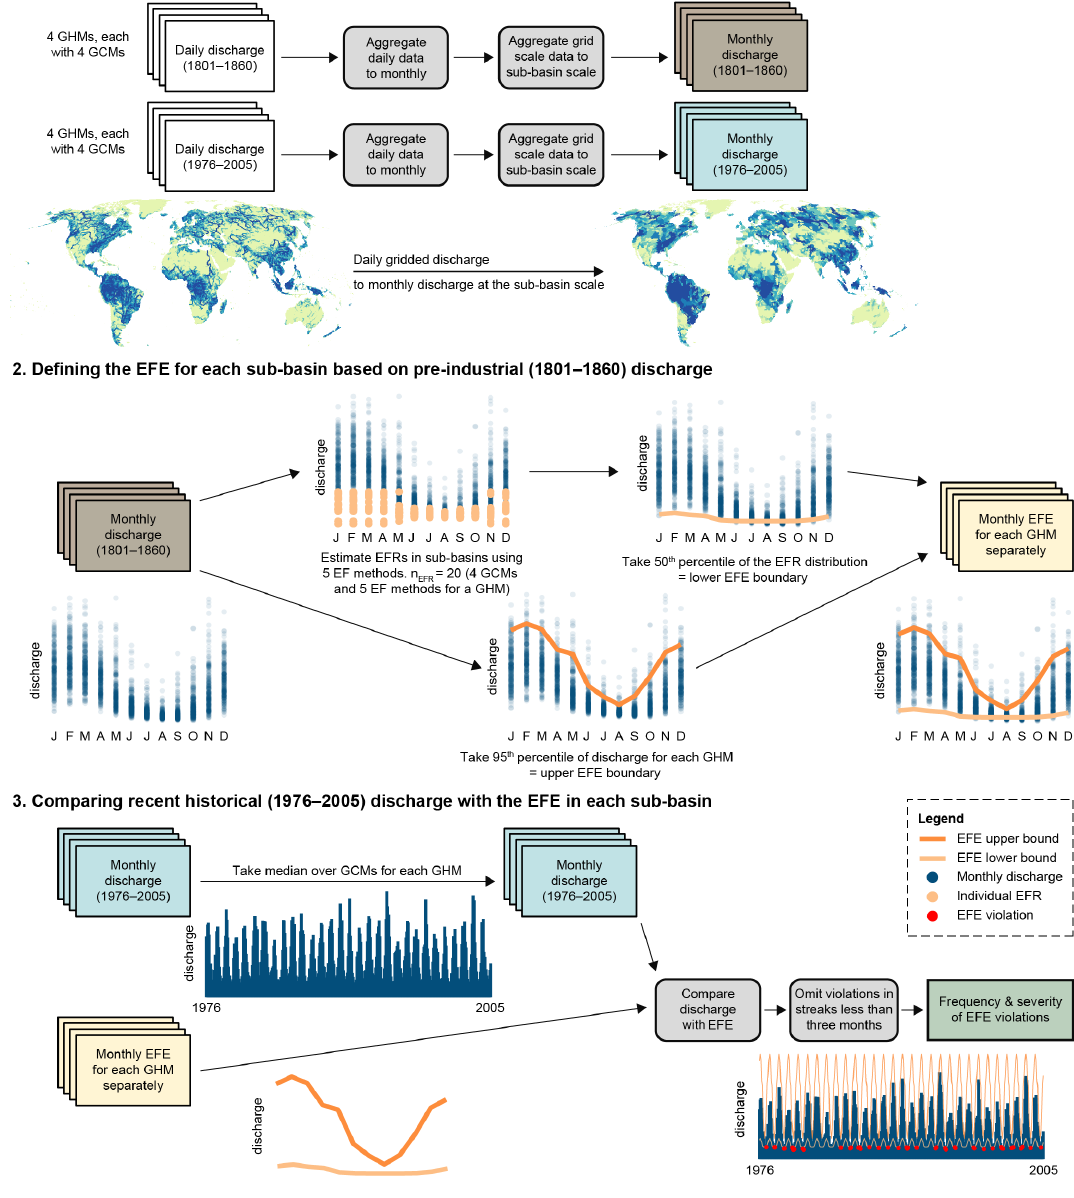
Figure 1. The methodological outline of this study: defining the environmental flow envelope (EFE) and estimating the frequency and severity of EFE violations in each sub-basin. GHM stands for global hydrological model, GCM for general circulation model, and EFR for environmental flow